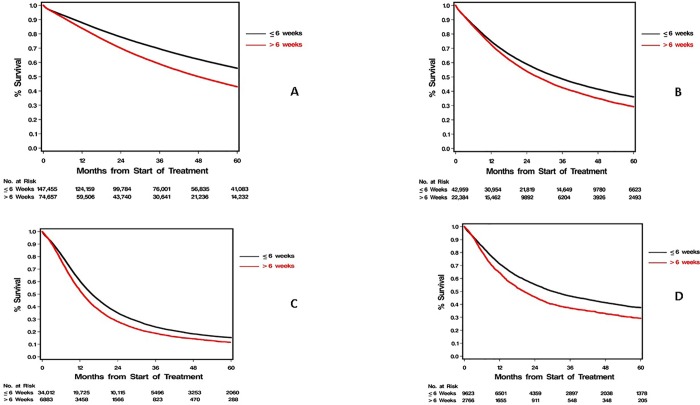
Overall survival by prolonged treatment delay in stages I and II non-small cell lung and pancreas cancers.Five-year overall survival for National Cancer Database patients with time to treatment initiation of six weeks or less was substantially higher when compared to patients with time to treatment initiation greater than six weeks for stage I (A) and stage II (B) non-small cell lung cancer and stage I (C) and stage II (D) pancreas cancers (P<0.001 for each).